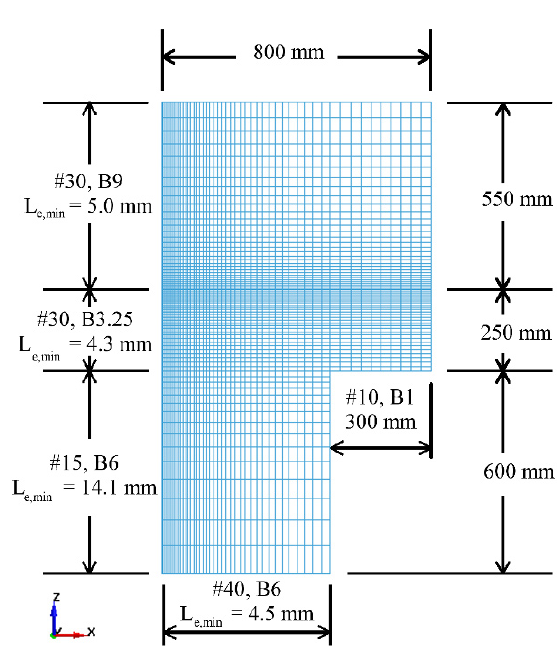
Figure 12. The XZ-view of the mesh distribution in the Eulerian do- main is shown, with a total of 174000 elements. Denser element distribution is located laterally towards the sym- metry axis as well as vertically towards the position of the target plate. Bias B indicates the ratio of the largest/smallest element length across a distance.